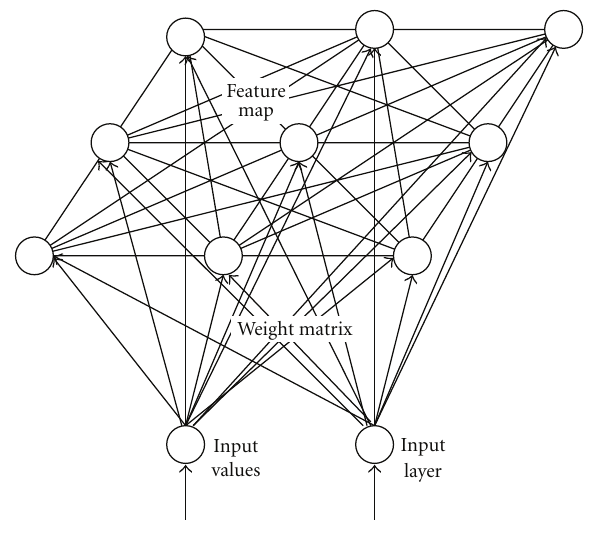
Figure 1: SOM network